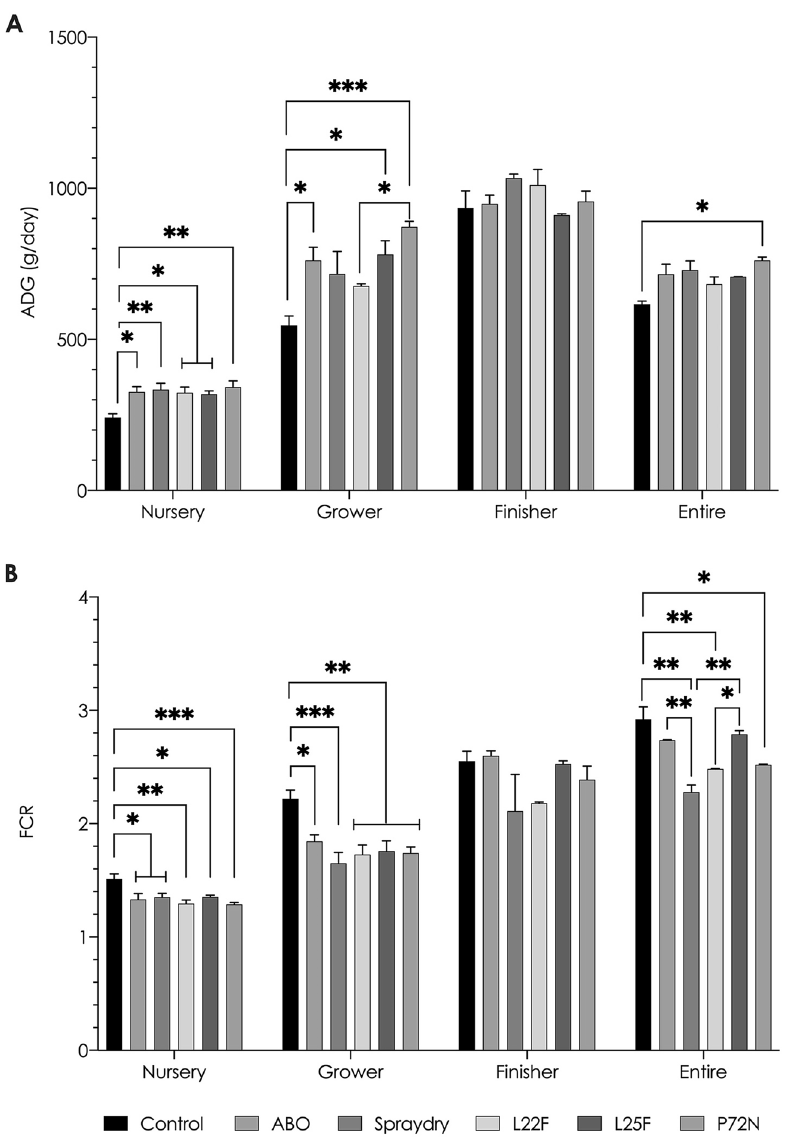
Figure 1. Effect of treatments on growth performance of nursery-finisher pigs. The asterisks represent statistically significant differences (* P < 0.05, ** P < 0.01 and *** P < 0.001).